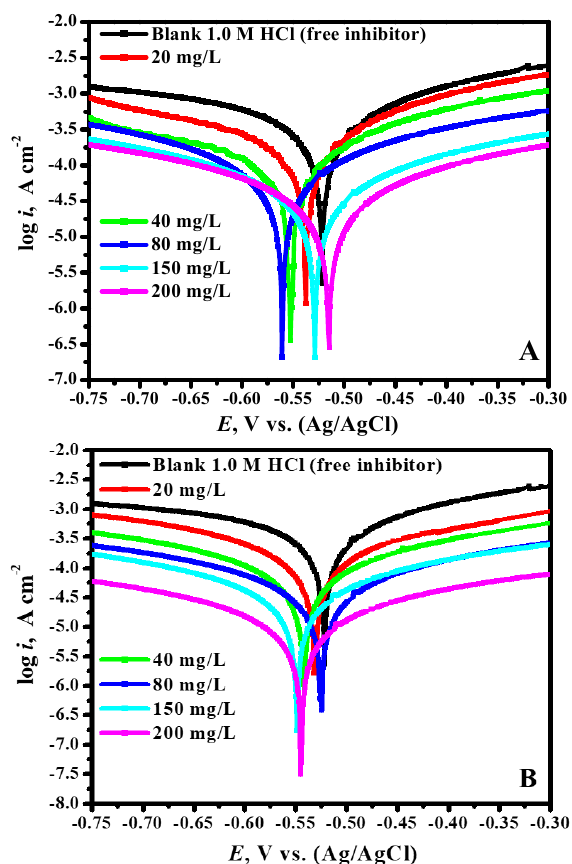
Figure 3. Polarization profiles for C-steel in molar HCl containing various doses of ( A ) Ad-Th and ( B ) Fe-Th at 50 °C. Table 1. PDP parameters and the inhibition capacitates derived for C-steel in molar HCl medium as